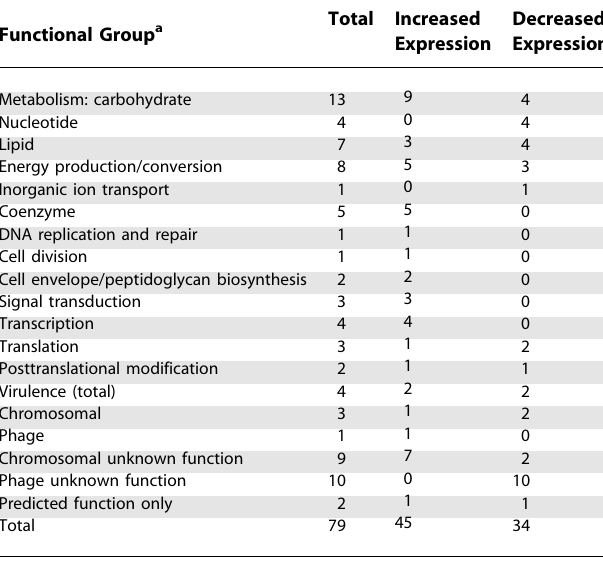
Table 2. Functional Categories of Streptococcal Genes Exhibiting Significant Changes in Expression during Adherence to Phar- yngeal Cells Compared with Associated Streptococcal Control Functional Group a